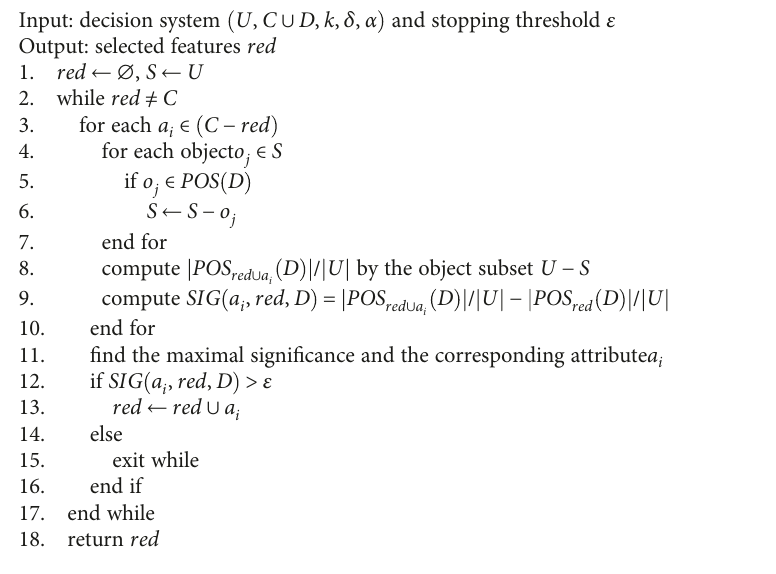
Table 4: Comparison of run times ( Data Algorithm 1: FSKNRS Algorithm 2: